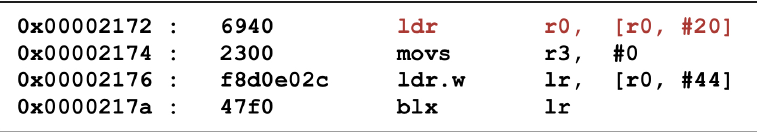
Figure 9. Function call